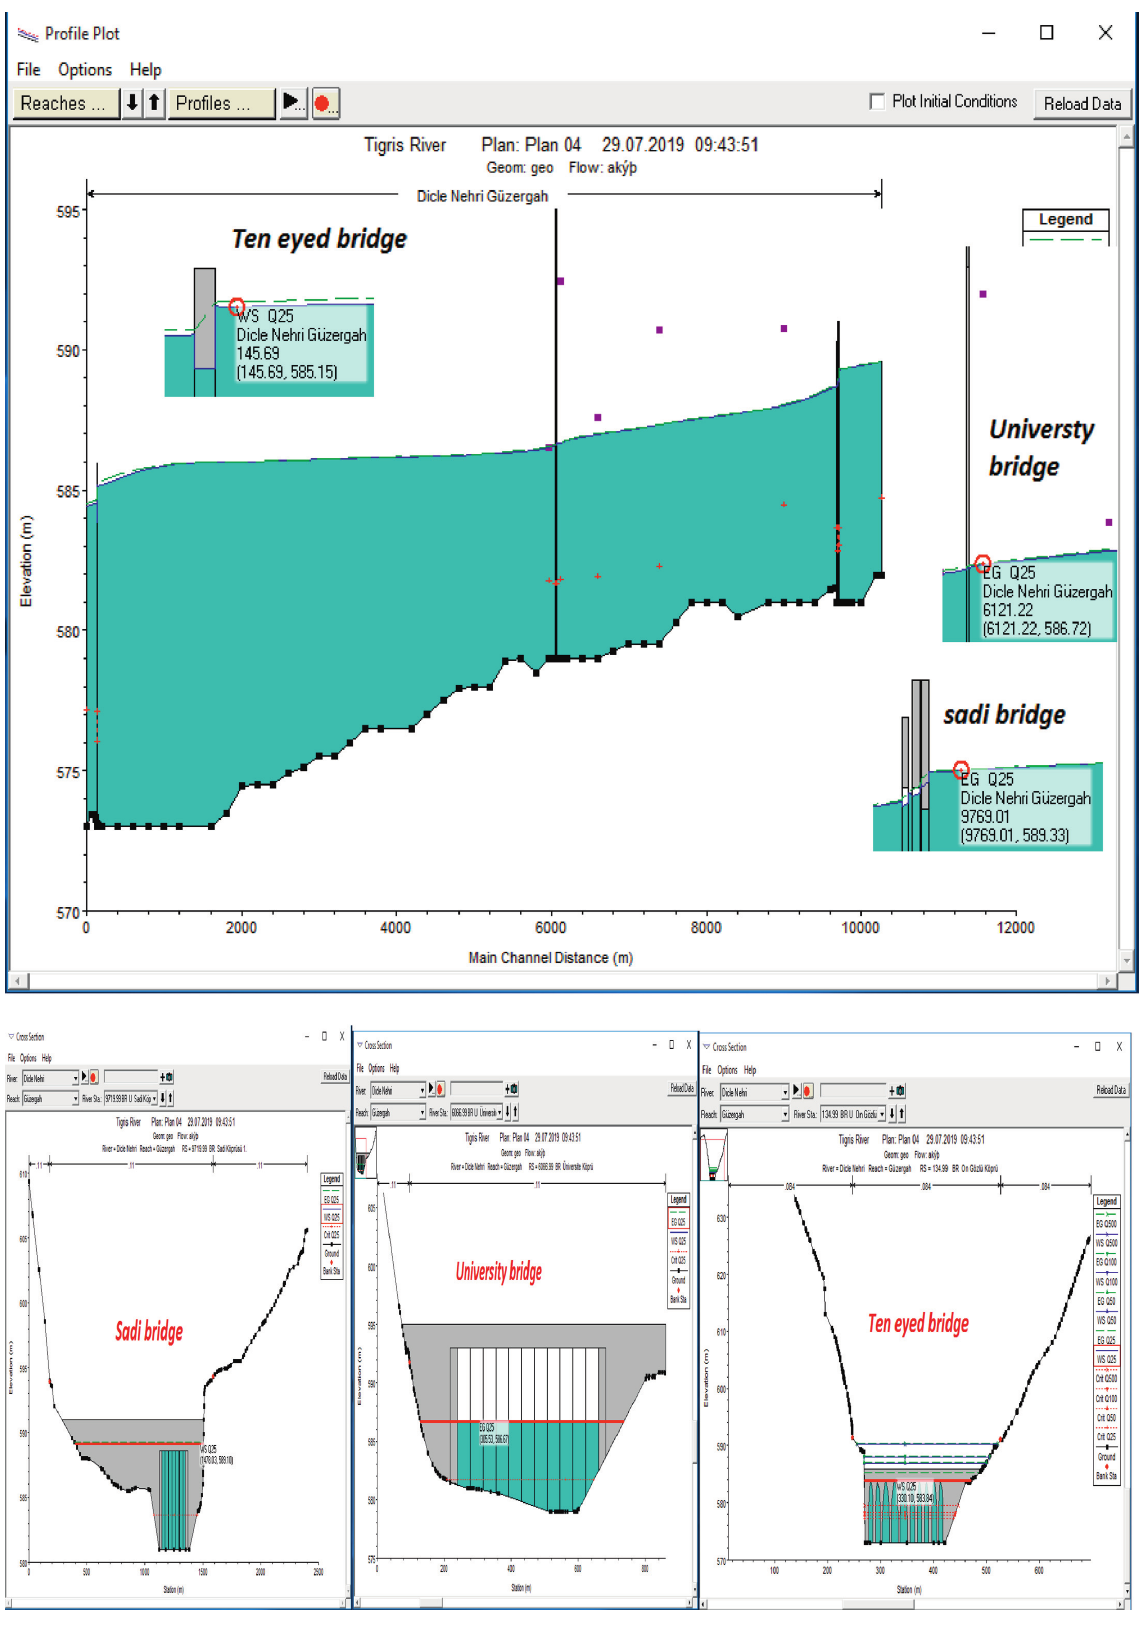
Figure 6: Water surface profiles for bridges ( Q